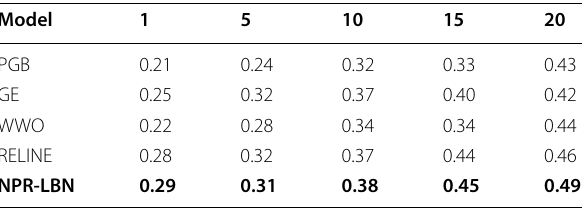
Table 5 Impact of additional information networks to the model